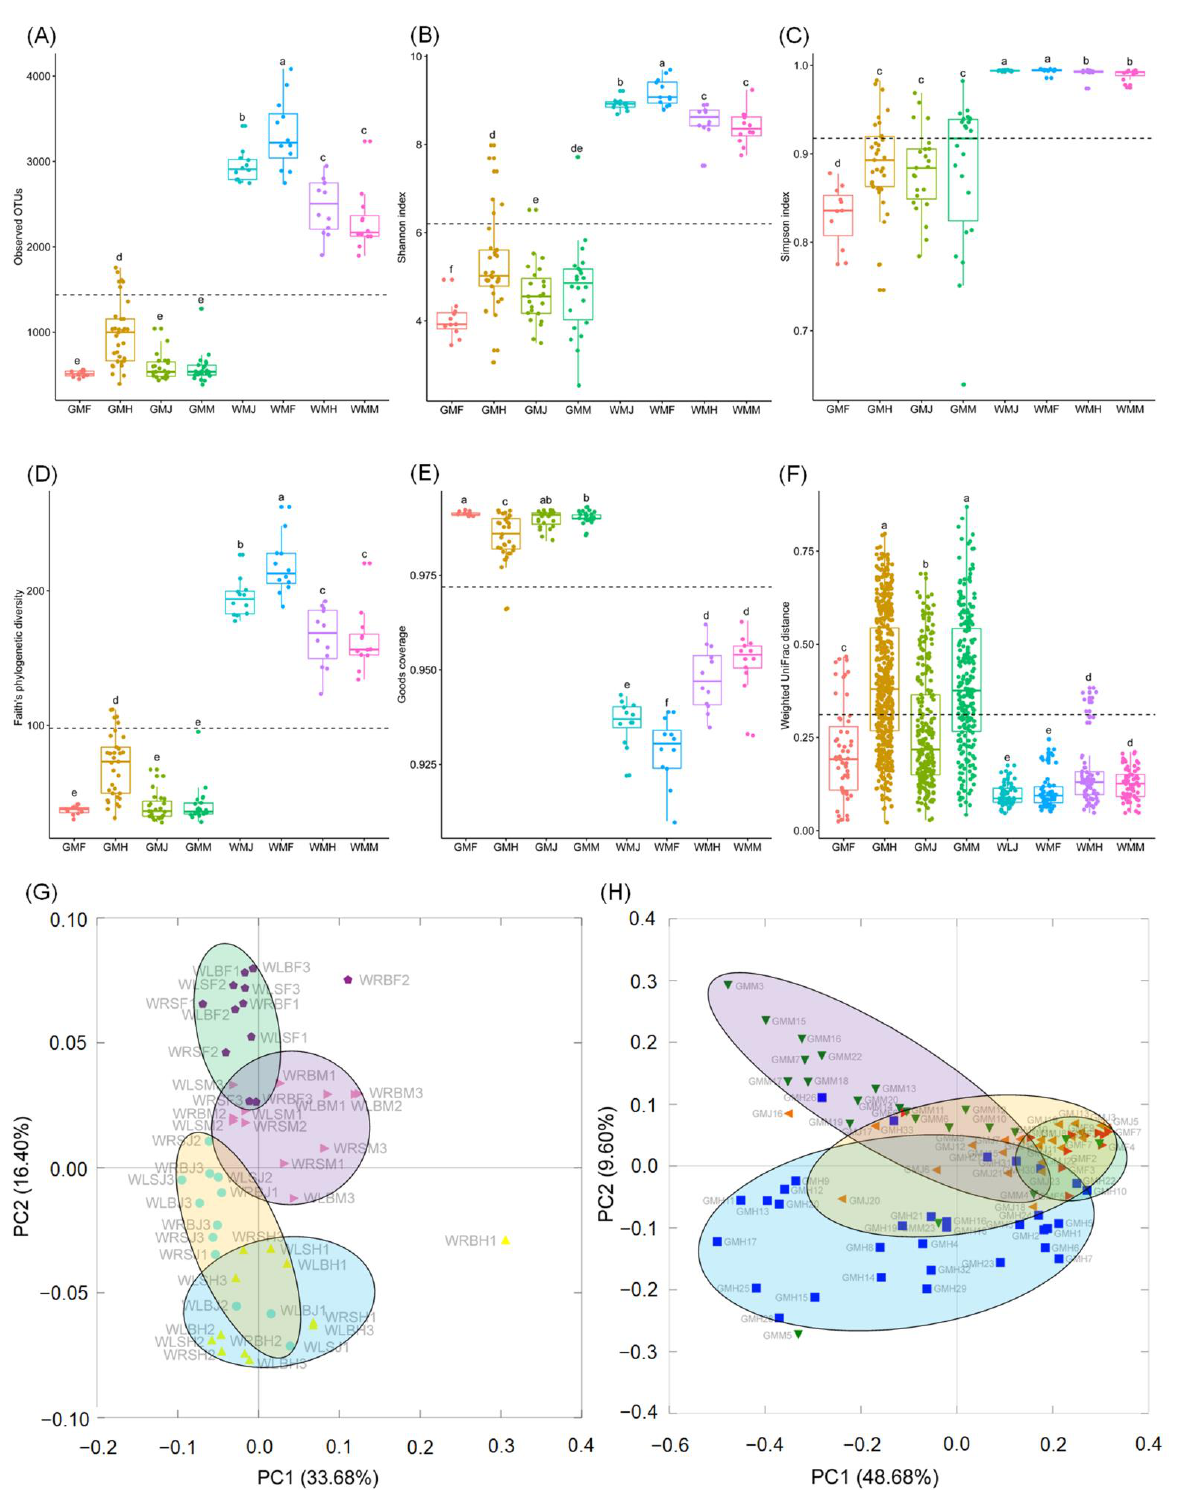
Figure 3. The changes in alpha diversity indexes ( A – E ), Weighted UniFrac distances ( F ), and water microbiota compositions ( G ) and Rhinogobio cylindricus gut microbiota compositions ( H ) as revealed by PCoA profiles, based on weighted UniFrac distance matrices at the operational taxonomic unit level. The different lowercase letters above the boxplots show the significant differences among the groups ( p < 0.05). GMH, gut microbiota of R. cylindricus collected at Hejiang; GMJ, gut microbiota of R. cylindricus collected at Jiangjin; GMM, gut microbiota of R. cylindricus collected at Mudong; GMF, gut microbiota of R. cylindricus collected at Fengdu; WMH, water microbiota collected at Hejiang; WMJ, water